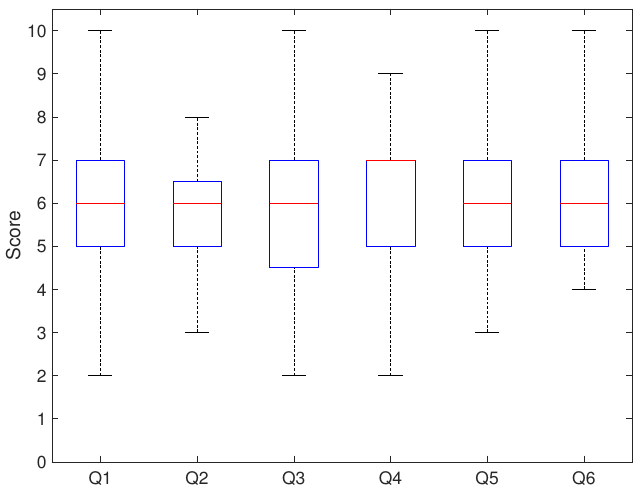
Figure 11. Points of each questionnaire question (last course).